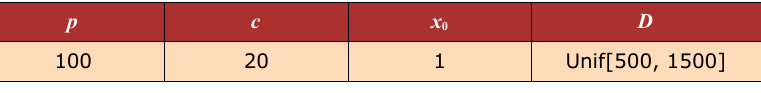
Table 1. Parameters